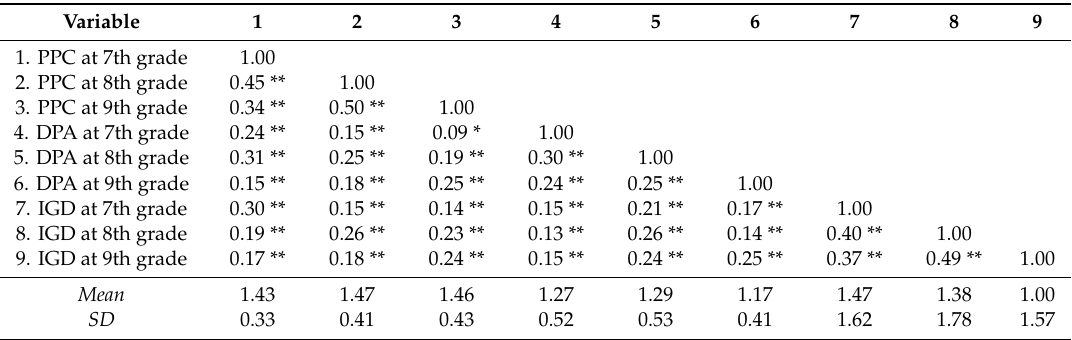
Table 1. Descriptive statistics and correlations for all variables ( N =